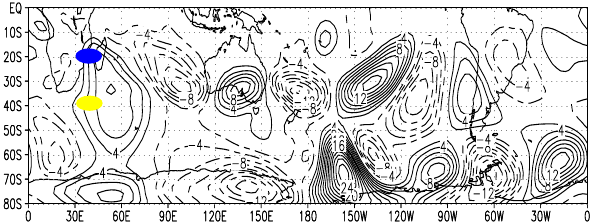
Fig. 10. Meridional wind component anomalies (ms − 1 ) at 250hPa Figure 10 : Meridional wind component anomalies (ms -1 ) at 250 hPa on day 14 of integration, on day 14 of integration, corresponding to the mean winter basic state experiment with the forcing at 40 ◦ E–20 ◦ S and 45 ◦ E–40 ◦ S corresponding to the mean winter basic state experiment with the forcing at 40ºE-20ºS and 45ºE-40ºS (see dots in the (see gray dots in the figure)